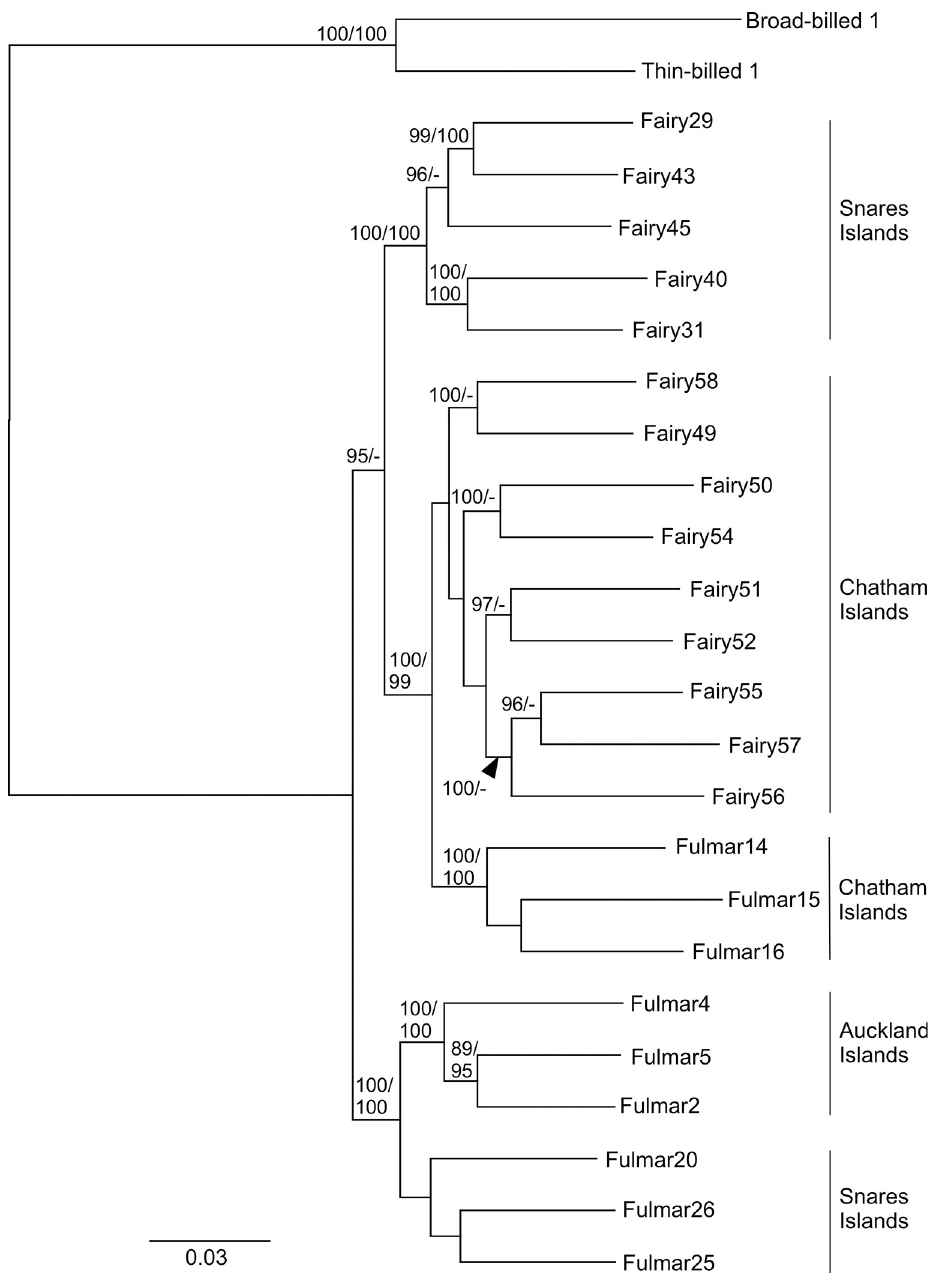
Fig 6. Maximum likelihood phylogeny constructed from 30677 SNPs from 9791 ddRADseq loci. Branch support values are given in the order SH-aLRT/UF-BS and are only shown when they are � 80%for SH-aLRT and � 95% for